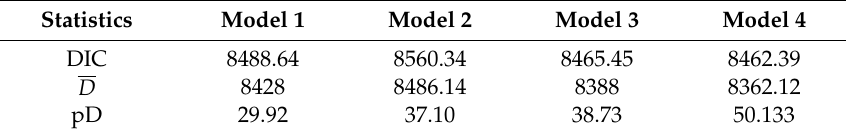
Table 4. Model comparison based on Deviance Information Criteria